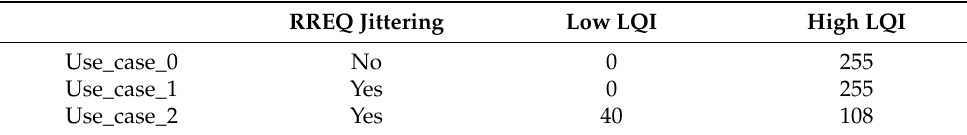
Table 2. Use cases for testing the Route Request (RREQ) jittering